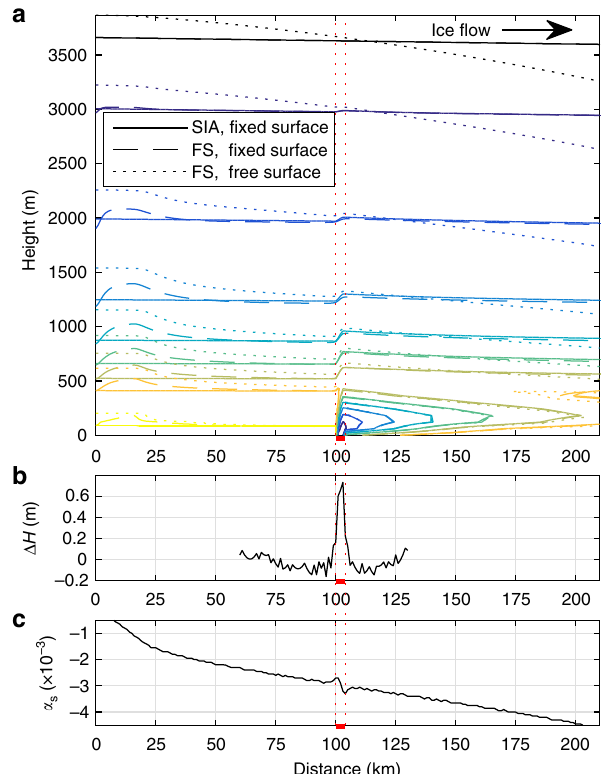
Fig. 4 Full-system modelling of freeze-on and comparison of internal layer structure resulting from simpli fi ed fl ow physics. a Comparison of basal accretion ( _ f ¼ _ a ¼ 0 : 25 ma (cid:2) 1 ) between SIA (solid line) and two FS calculations, with (1) fi xed surface (dashed line) — as for the SIA case — and (2) for a free surface (dotted line), where all three were calculated with the fi nite-element model Elmer/Ice 38 . All show characteristic sharp upward bending of isochrones over the accretion extent (red line) and closely matching plume layer structure. b Difference between detrended (polynomial of degree 2) and original surface from FS free-surface run, showing the surface expression of the plume. c Surface-slope α s over 1 km grid. Note, surface expression of plume leads to a change in surface-slope α α α s , with increasing s over the accretion area and decreasing s upstream and downstream of the accretion area. The boundary of the accretion area (red horizontal bar) is shown for all three subplots (red dotted